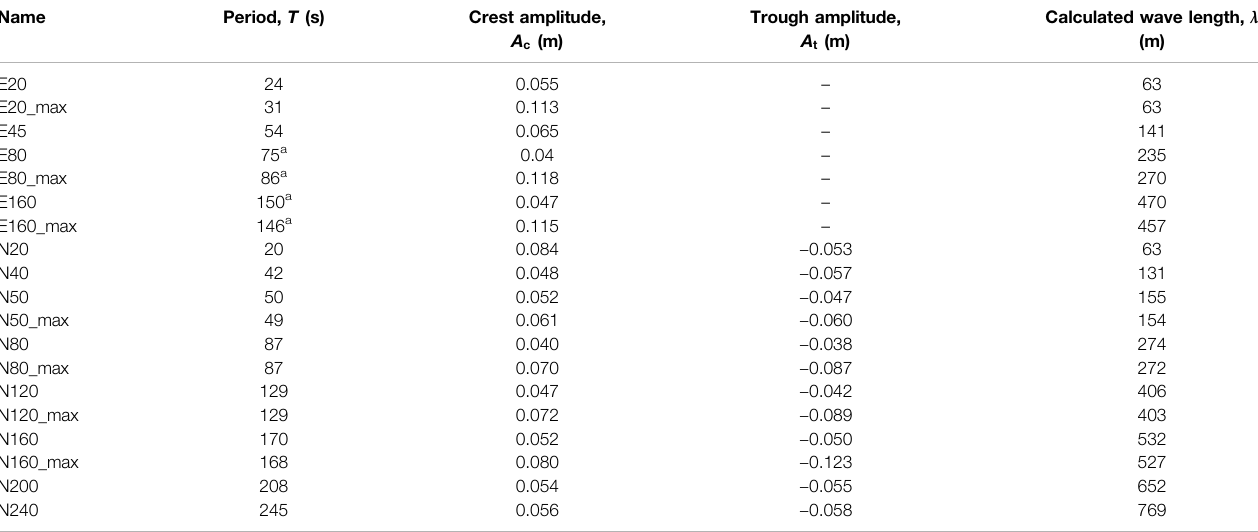
TABLE 2 | Calibrated crest only (elevated) waves and N-waves using third generation